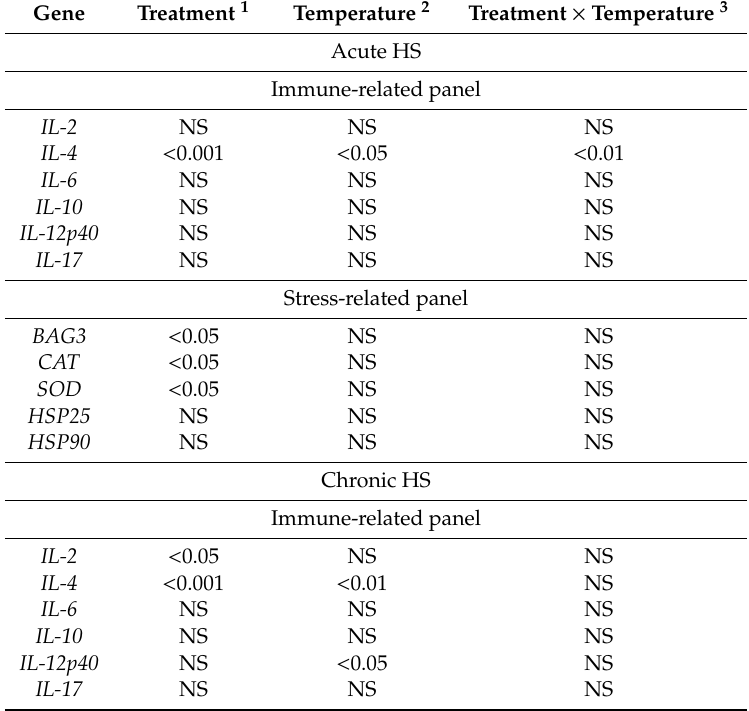
Table 3. E ff ects of in ovo treatment and ambient temperature on gene expression signatures in the spleens of slow-growing